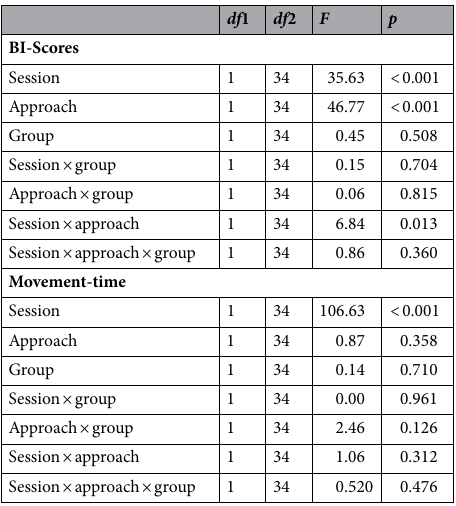
Table 1. Overview of the behavioral results from the movement selection task. Reported are the results of the repeated measures ANOVA of BI-Scores and